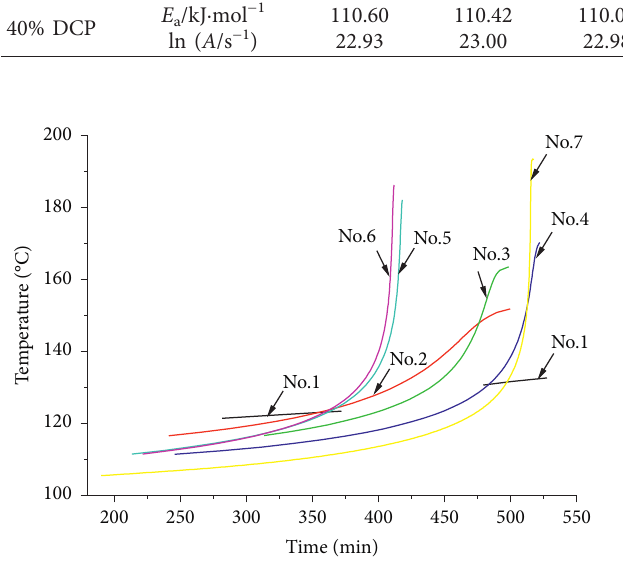
Figure 4: T - t of exothermic section for sample #2.